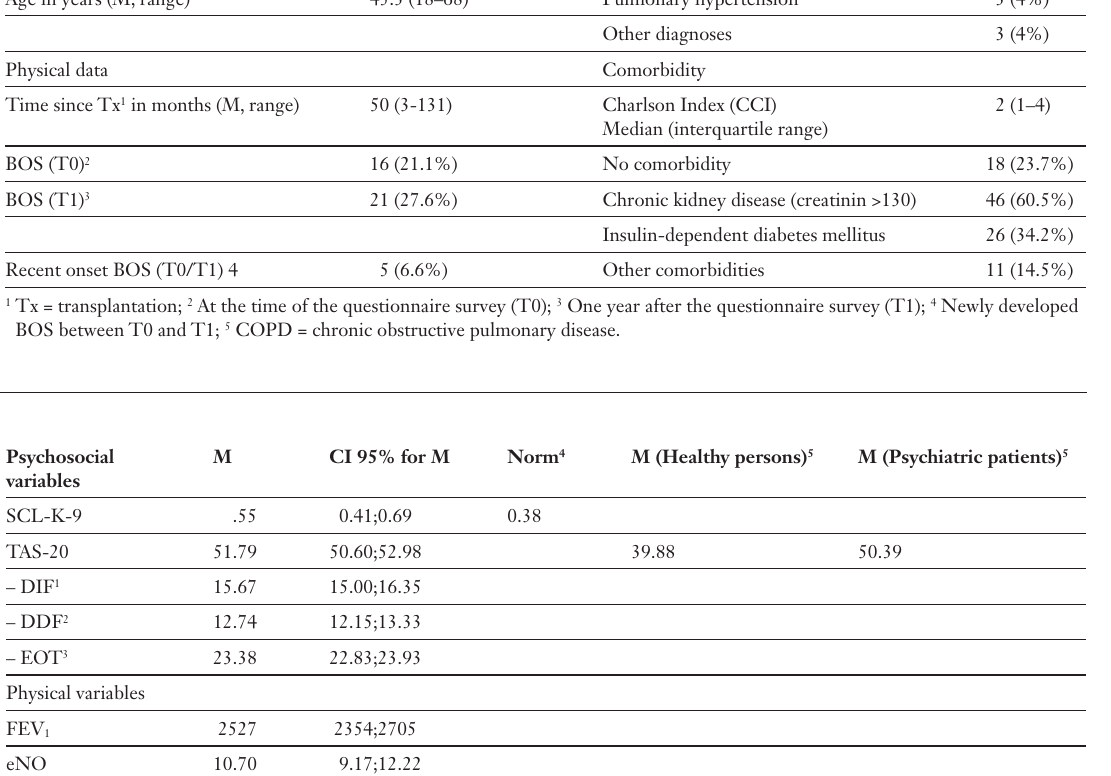
Sociodemographic data, physical data, diagnoses and comorbidity, n = 76.